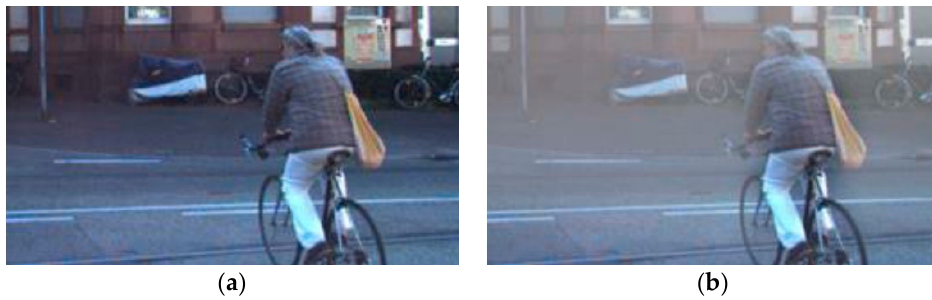
Figure 1. Clear image and hazy image: ( a ) clear image; ( b ) hazy image. Each image pixel value in hazy images can be expressed with atmospheric scattering model, a linear combination of the pixel values from actual image, transmission image, and airlight [22–24]. Airlight and transmission images are required to perform scene radiance recovery through the scattering coefficient model.